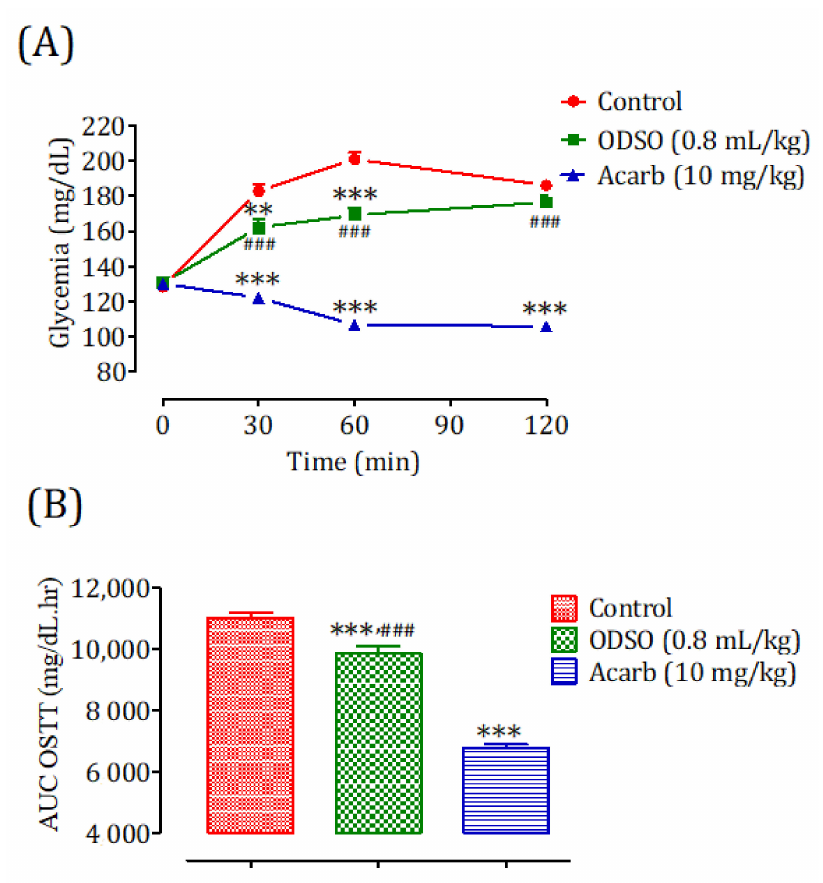
Figure 8. Effect of ODSO and acarbose on the change in the postprandial glycemia in diabetic rats ( A ), with a representation of the area under the curves ( B ). ODSO: Opuntia dillenii seed oil. The values are the means ± SEM ( n = 6). ** p < 0.01 and *** p < 0.001 compared to the control and ### p < 0.001 compared to the acarbose